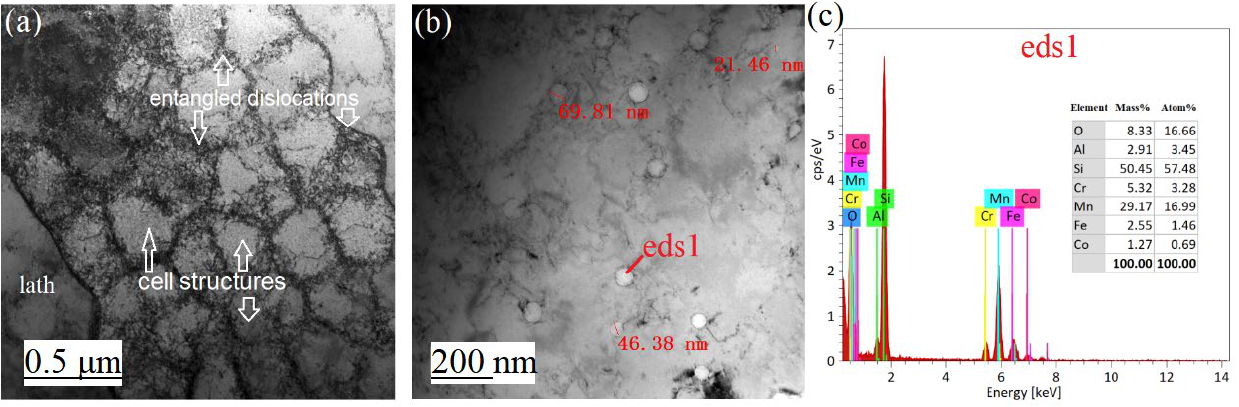
Figure 8. TEM analysis of SLM sample: ( a ) cellular structures and dislocations, ( b ) spherical nano- precipitates, ( c ) EDS of spherical nano-precipitate.